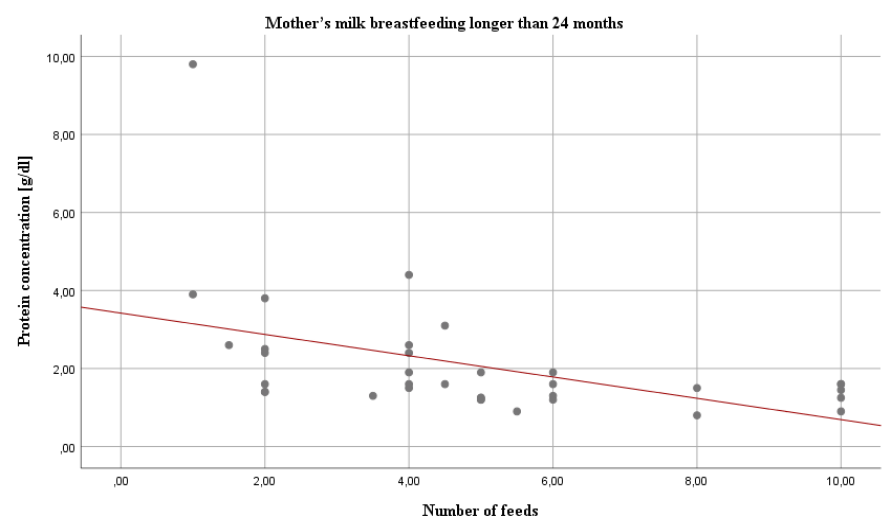
Figure 2. Relation between the concentration of protein and the amount of feeding in mother’s milk over 24 months of lactation. The number of feedings in the analyzed group ranged from 1 to 10 per day.